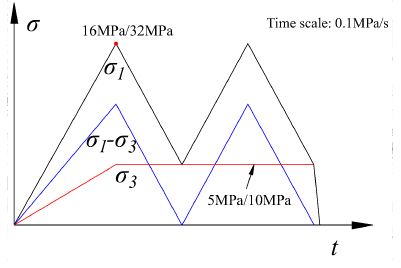
Figure 7. Stress paths used for the